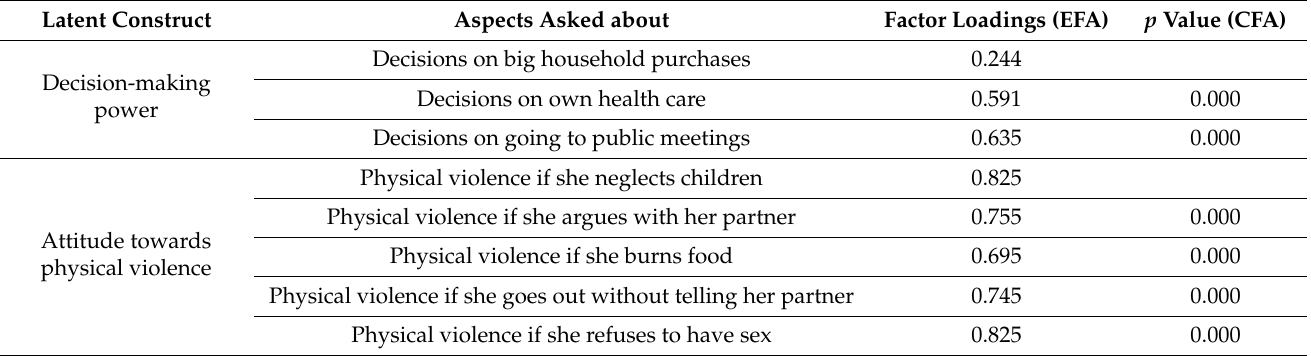
Table 5. Factor analysis for indicators of empowerment (n = 746), Jimma Zone, Western Ethiopia, 2020. Latent